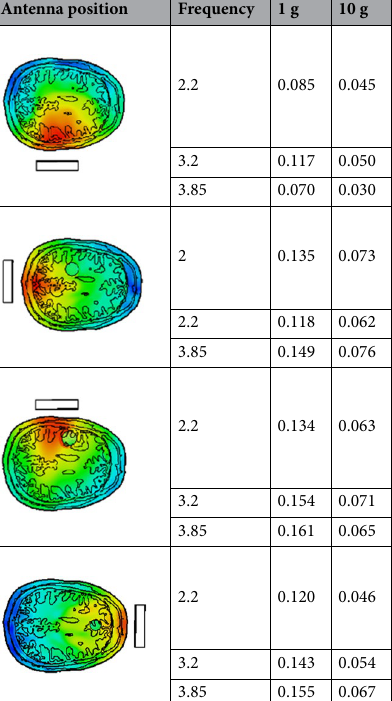
Antenna position Frequency 1